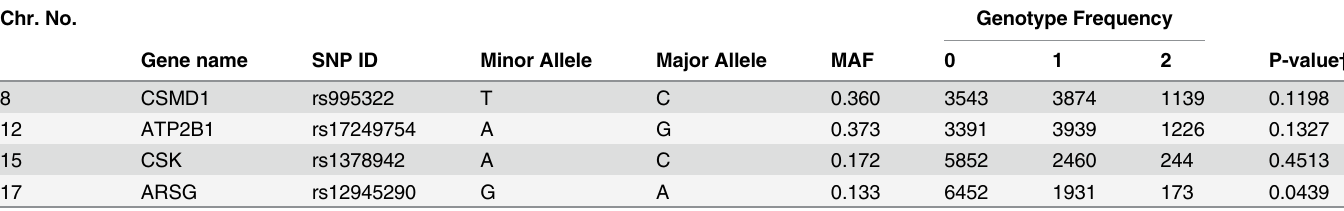
Table 1. Hardy-Weinberg equilibrium and genotype frequencies for 4 SNPs included in the genetic risk score. Chr. No.